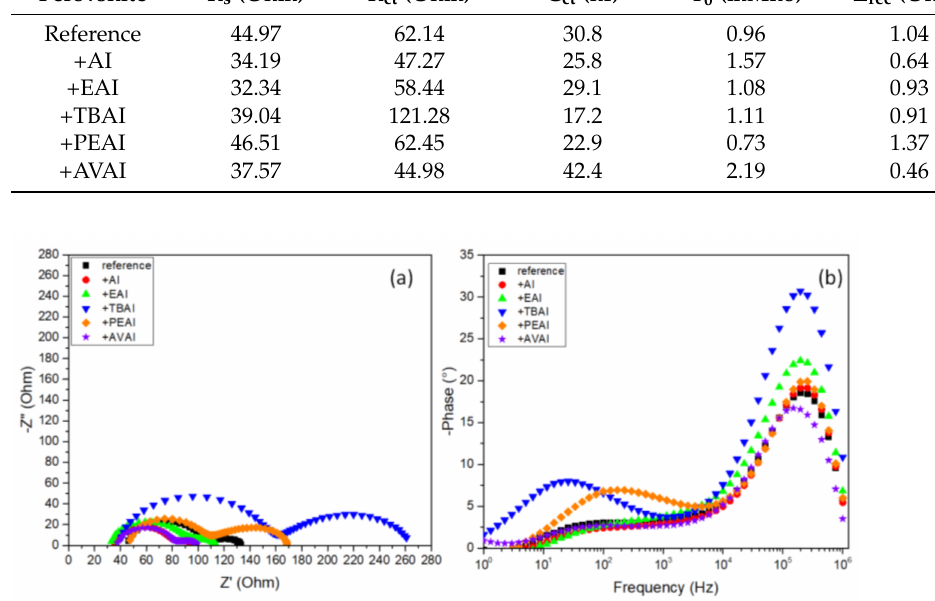
Figure 6. ( a ) Nyquist plots and ( b ) Bode phase plots obtained from Electrochemical Impedance Spec- troscopy (EIS) measurements performed on the C-PSCs incorporating the 6 perovskites under study.